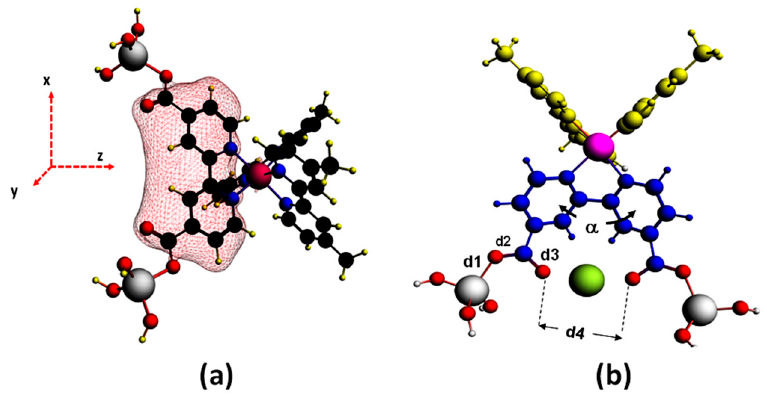
Figure 32. ( a ) Electrostatic potential in complex 1(T 1 ). ( b ) Atomic distances and bond angles for the 1(T 1 1(T 1 )Li. Table 6. Atomic distances (A) and bond angles (°) for the lithium adduct.